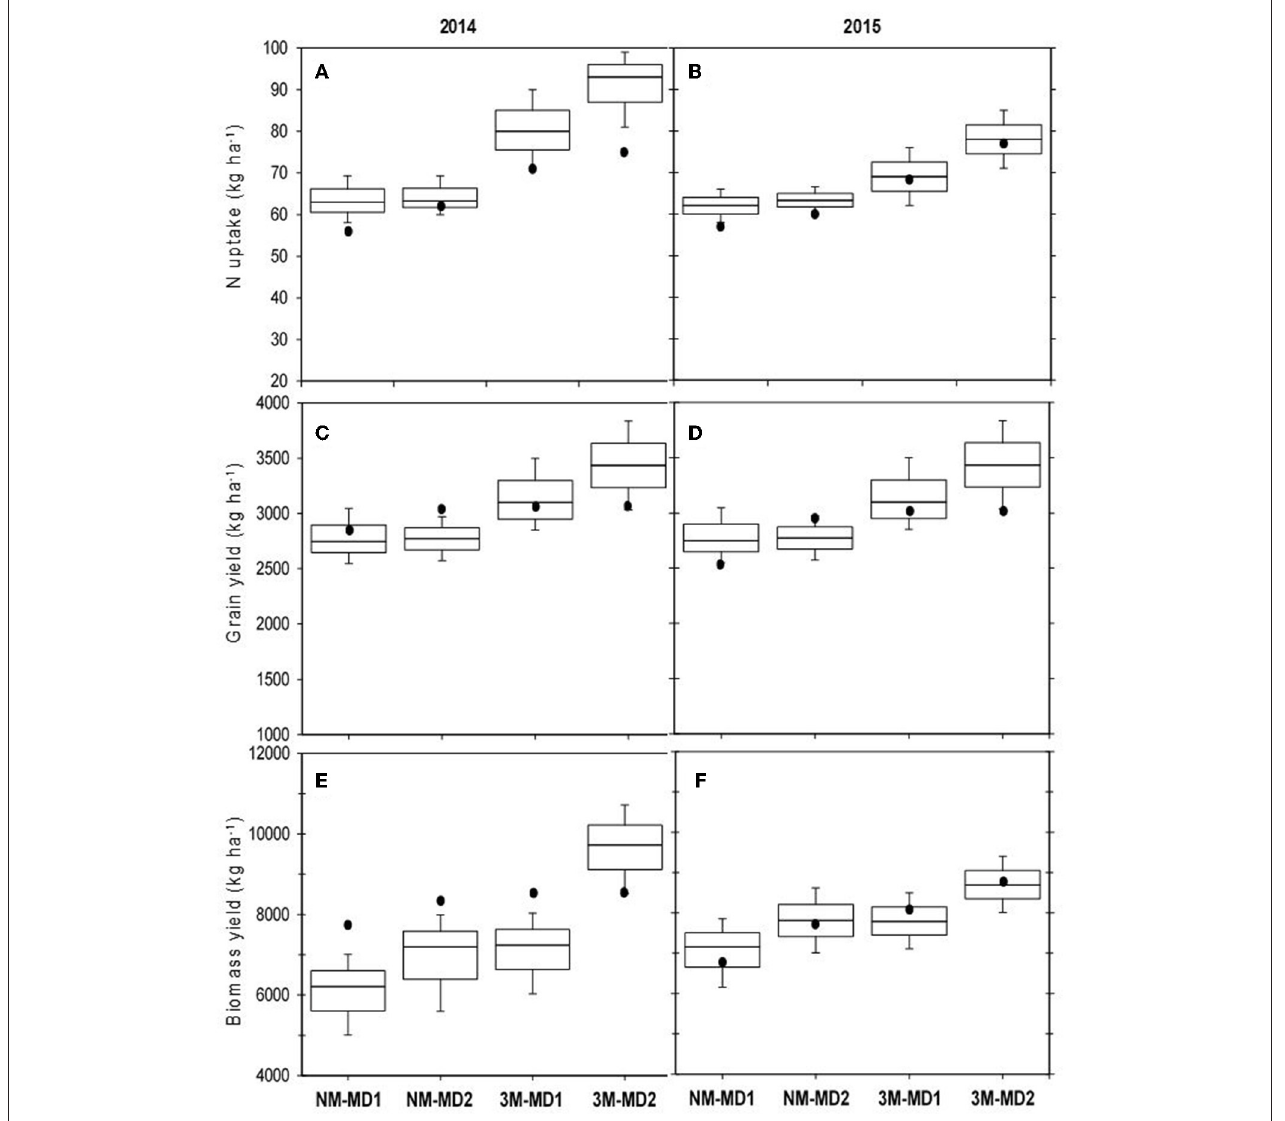
FIGURE 5 | Comparison between observed (box-and-whisker plots) and simulated (black points) N uptake (A,B) , maize grain (C,D) , and aboveground biomass (E,F) yield at harvest as affected by combined application of 0 (NM) or 3 (3M) t ha − 1 of manure and two microdosing rates (MD1–MD2) in 2014 and 2015 using CTCNP2 = 0.20. MD1 = microdosing option 1; MD2 = microdosing option